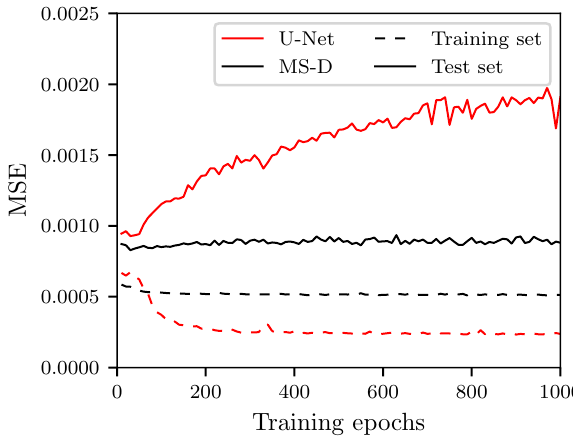
Figure 11. Oatmeal dataset, method B: the mean square error for MS-D and U-net calculated on the central slice of the training and test set. The training error decreases as the networks are trained longer. The test error of the U-net increases, whereas the test error of the MS-D network remains